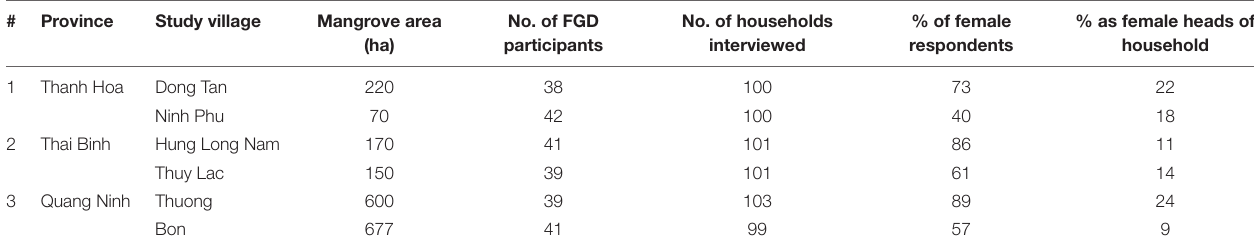
TABLE 3 | FGD and household interview sample sizes in the study